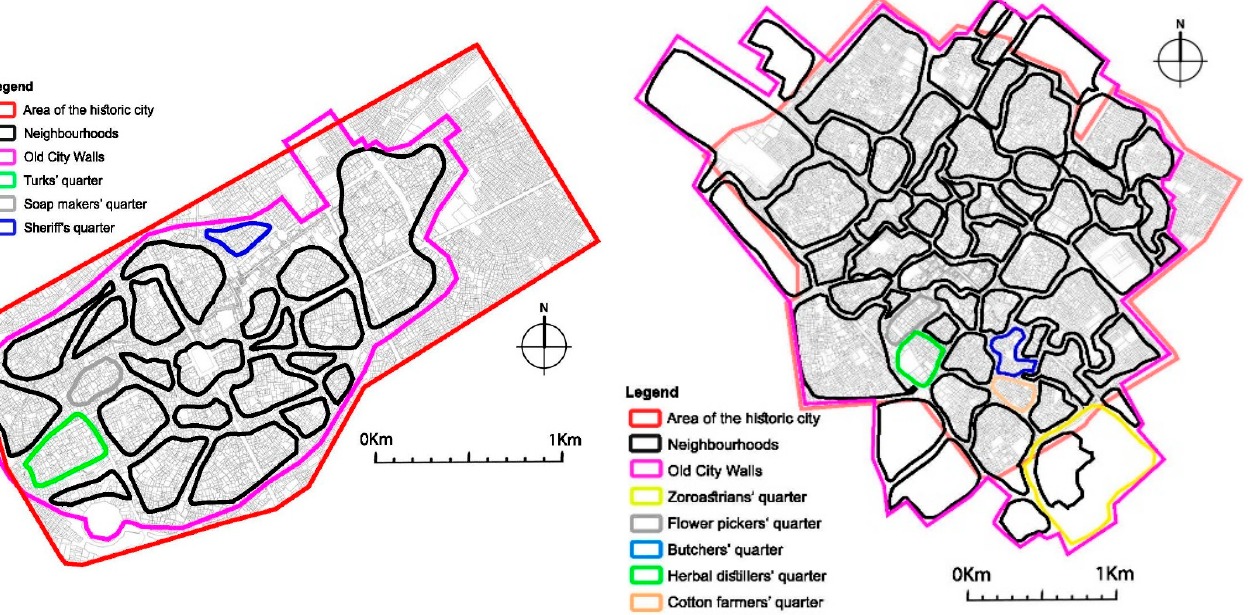
Figure 2. Heterogeneous neighbourhoods in the medieval city of Yazd ( right ) and Kashan ( left ) were formed as a result of the accumulation of people with mutual religious identities or similar types of occupations in one place [31] .